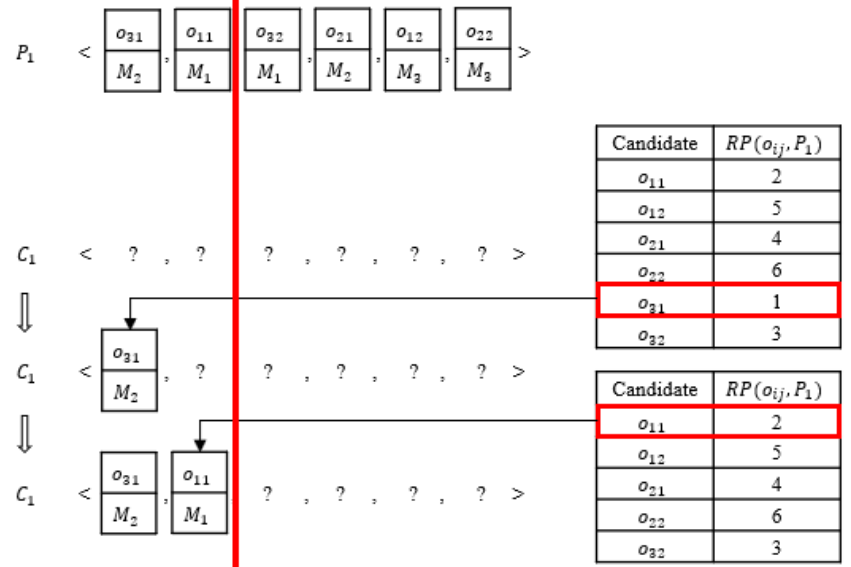
Figure 4. Generating the earlier part of the offspring solution.